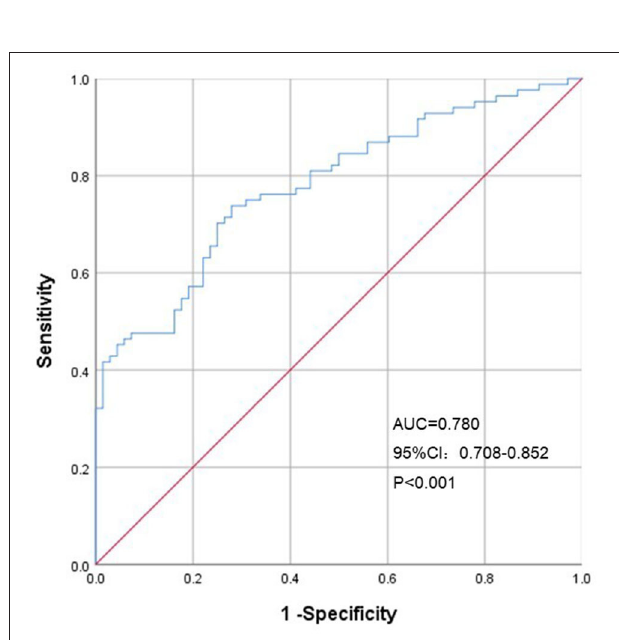
FIGURE 6 | Receiver operating characteristic curves of predicted FMD for Framingham Heart Study CV risk stratification. AUC, area under the curve; CI, confidence